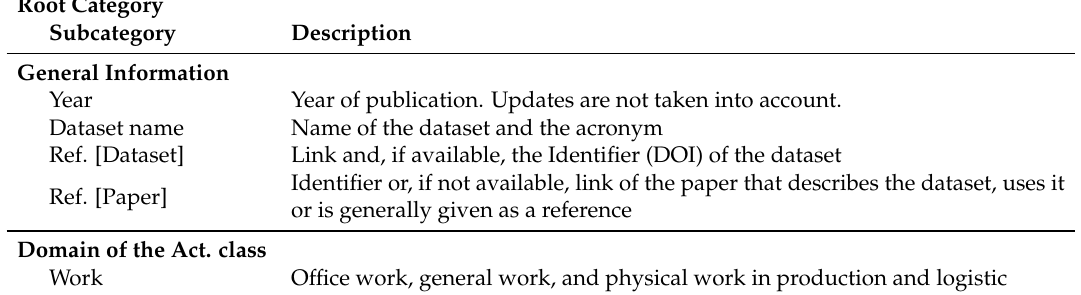
Table A3. Categorization scheme.